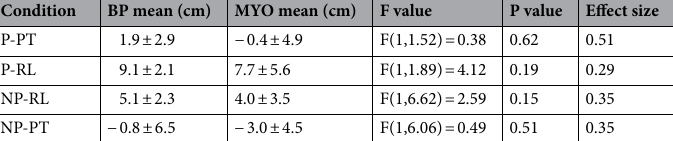
Table 3. Average estimation error for BP and MYO prosthesis